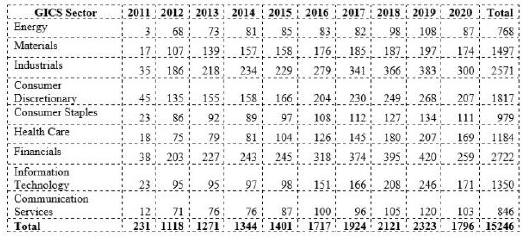
Table 1b: Samples by Industrial Sectors